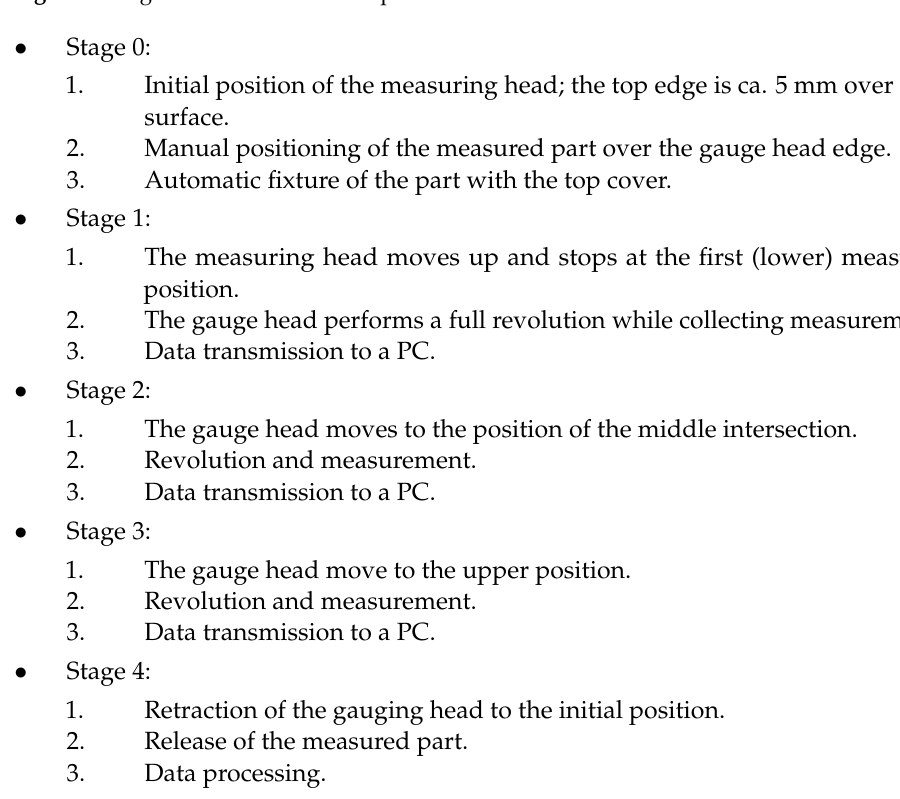
Figure 2. Stages of the measurement